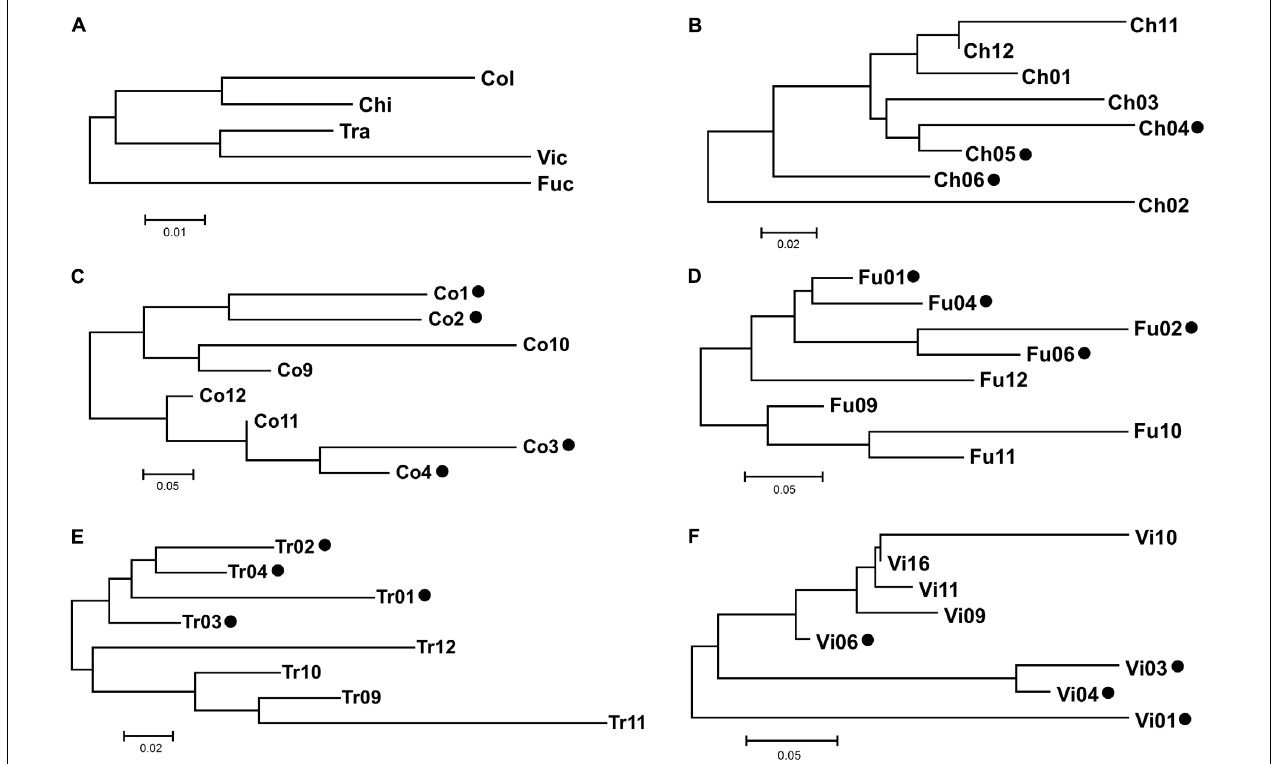
FIGURE 5 | Neighbor-Joining dendrograms based on Slatkin’s linearized F st matrix. The codes of sampling sites were reported as in Table 1 . Scale bar indicates Slatkin’s linearized F st value of genetic distance. (A) The genetic distance among the five population surveyed. The dendrograms from (B–F) indicate the genetic distance among the sampling sites within a population. Black dots indicate the flooded status of the sampling sites.